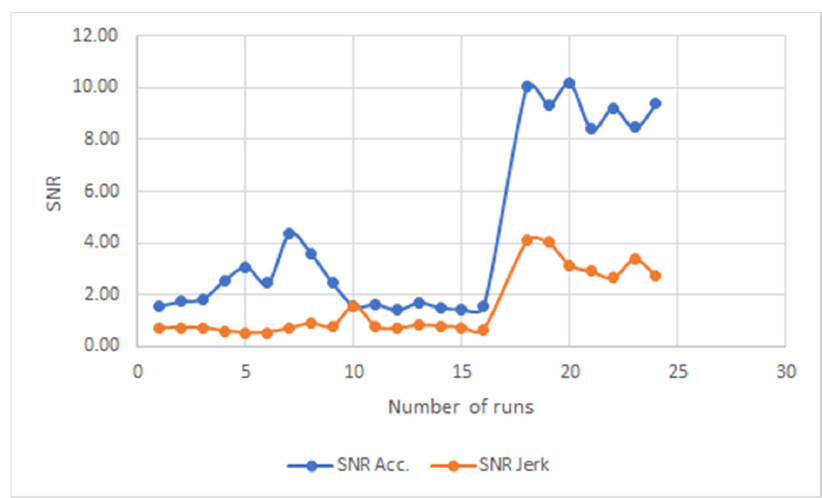
Figure 5. SNR for experienced users, both disabled and temporary.